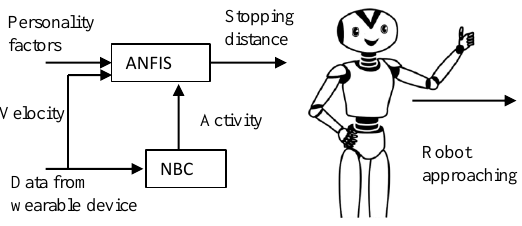
Figure 10. An overview of the system proposed in [71].